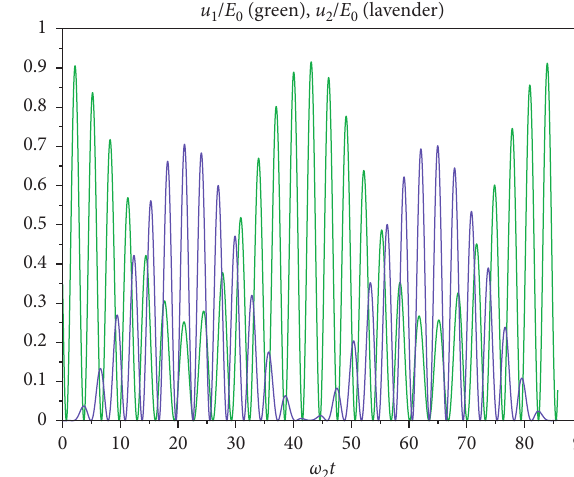
Figure 6: Plots of x ( t ) and y ( t ) versus time. Figure